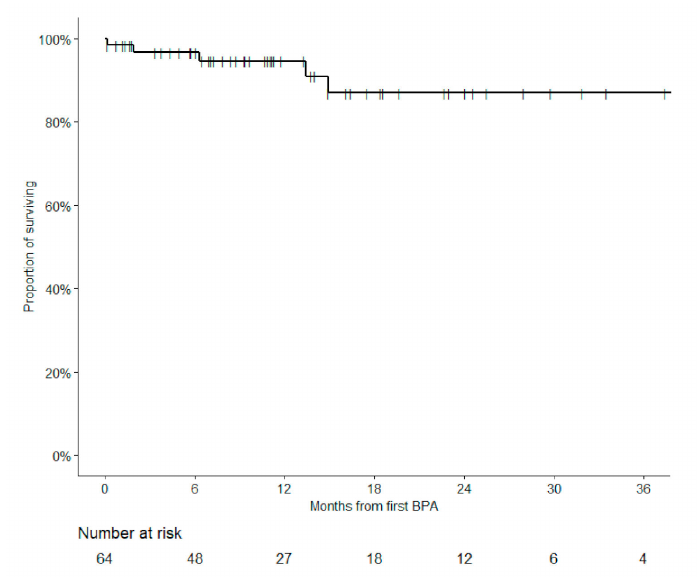
Figure 5. Overall survival of all 64 patients with at least one BPA